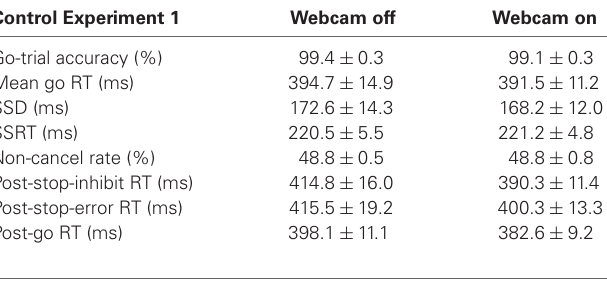
Table 2 | Summary of the Control Experiment 1 results (mean ± standard error).